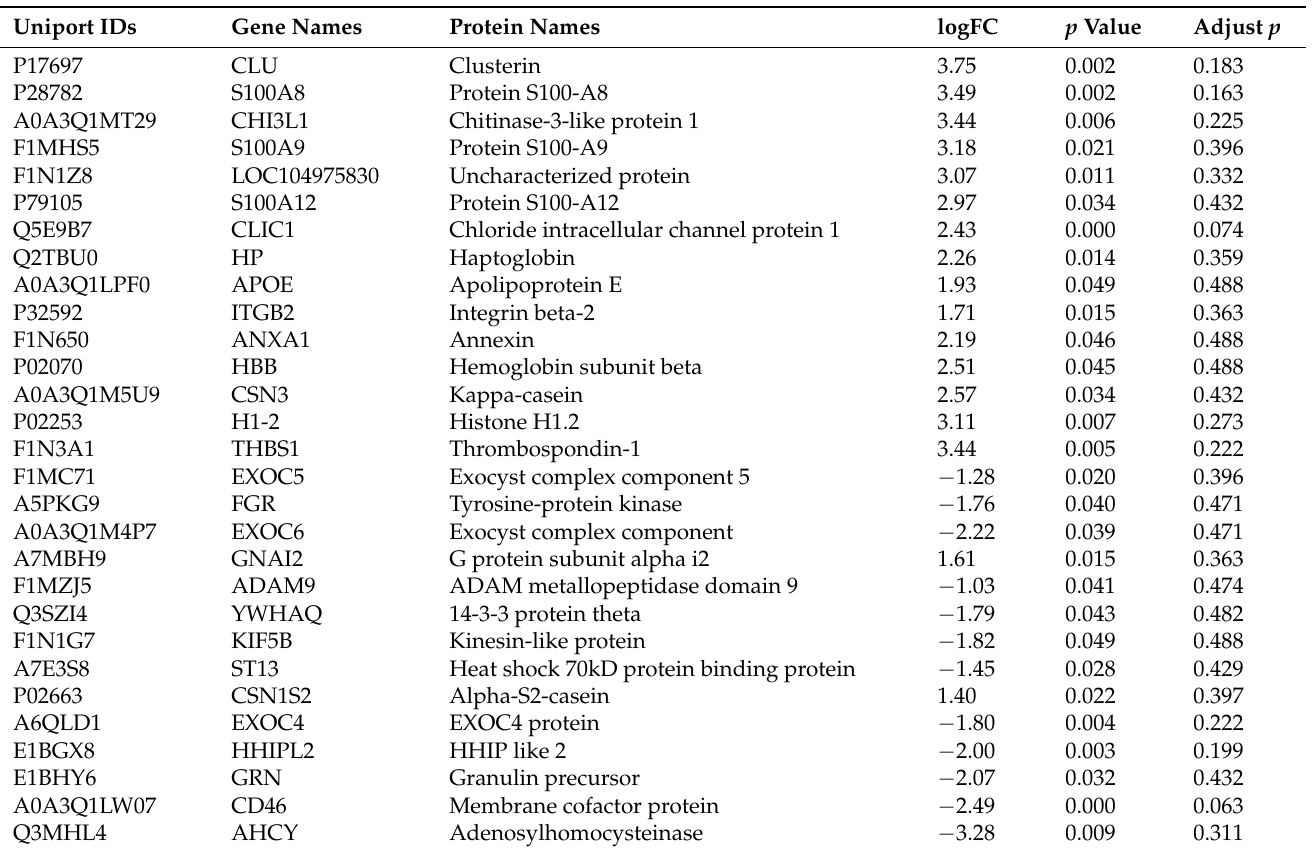
Table 2. Statistic analysis of the selected proteins in milk-derived EVs between the SM and Healthy group by moderated t -test. Log FC, Fold change calculated as SM/Healthy and expressed on a log2 scale. Adjust p , corrected by the Benjamini–Hochberg method.